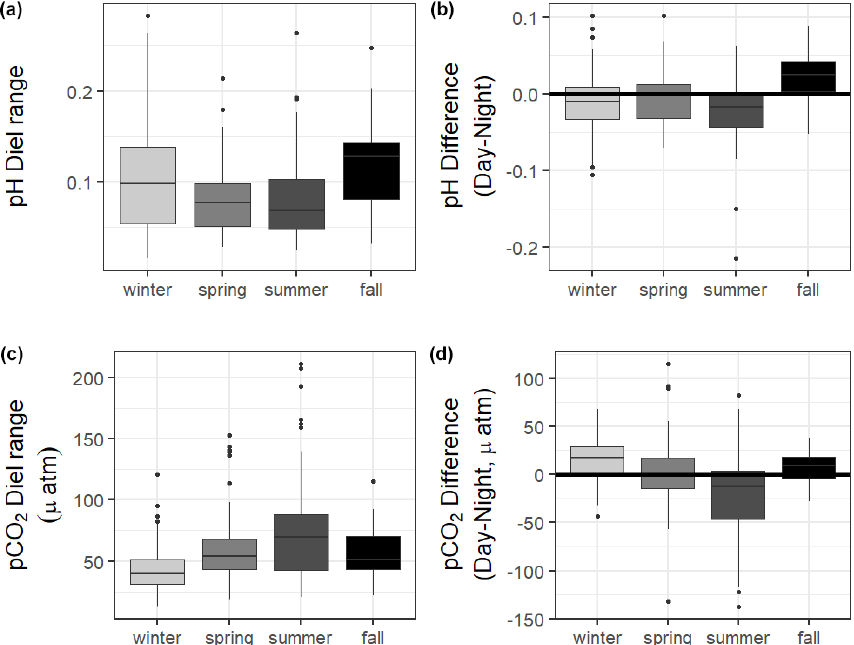
Figure 4. Boxplots of the diel range (maximum minus minimum) and difference in daily parameter mean daytime minus nighttime measure- ments for pH and p CO 2 from continuous sensor